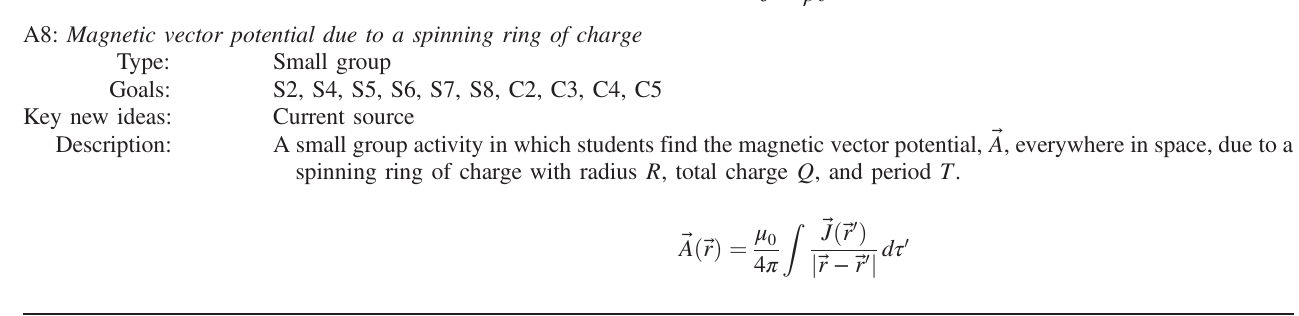
A7: Steady current/current density Type: Kinesthetic Goals: Key new ideas: Steady current, current density (linear Description: A kinesthetic activity in which students, representing point charges, are asked to move so as to make an imaginary magnetic field meter register a constant magnetic field, introducing “ steady current ” as a concept. Students act out linear measure these quantities.